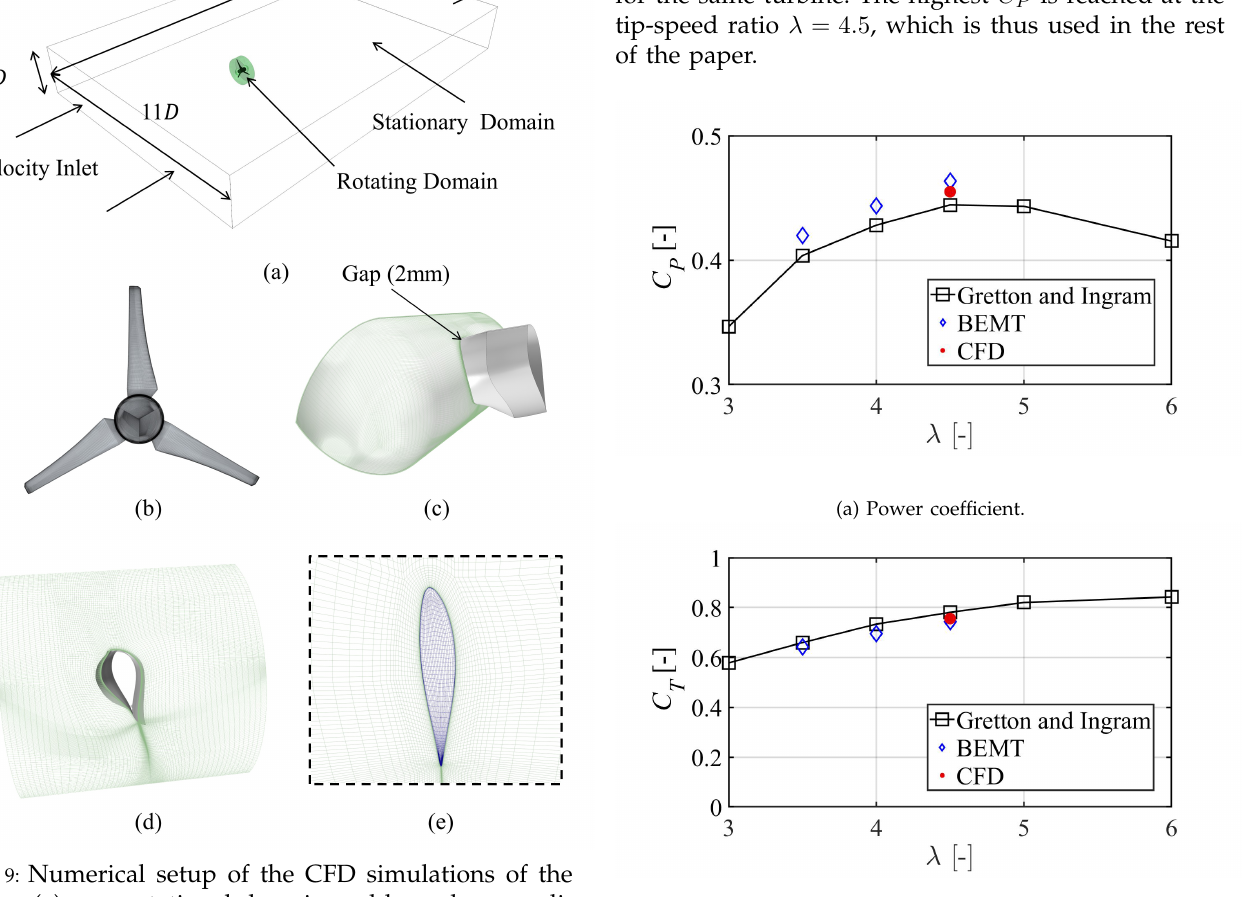
Fig. 10: Power ( C P ) and thrust ( C T ) coefficient of the rotor with three fixed-pitch blades versus the tip-speed ratio ( λ ) predicted with BEMT and CFD, and comparison with the CFD results by Gretton and Ingram